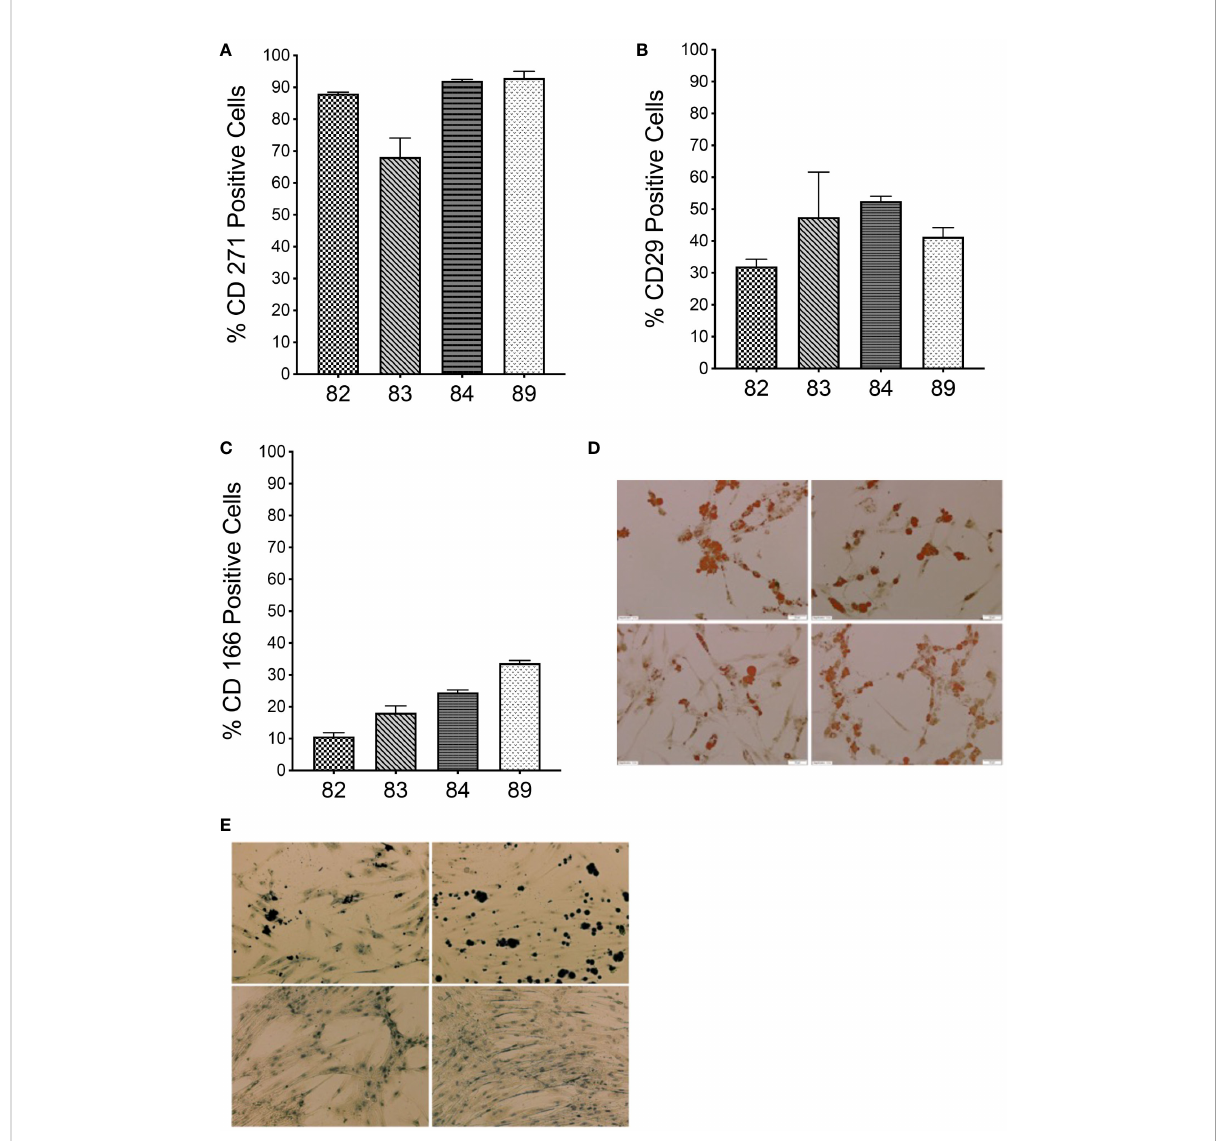
FIGURE 1 Characterization of autologous BM-derived MSCs. (A – C) Flow cytometric analysis of MSCs isolated from sheep bone marrow for CD271, CD29, and CD166 markers. (D) Oil Red O staining of MSCs from each sheep after differentiation into adipogenic lineage. (E) von Kossa staining